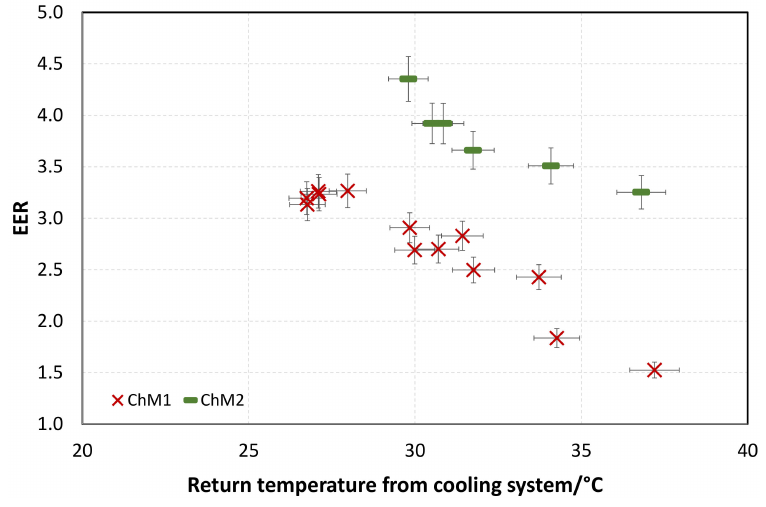
Figure 16. EER for different charging